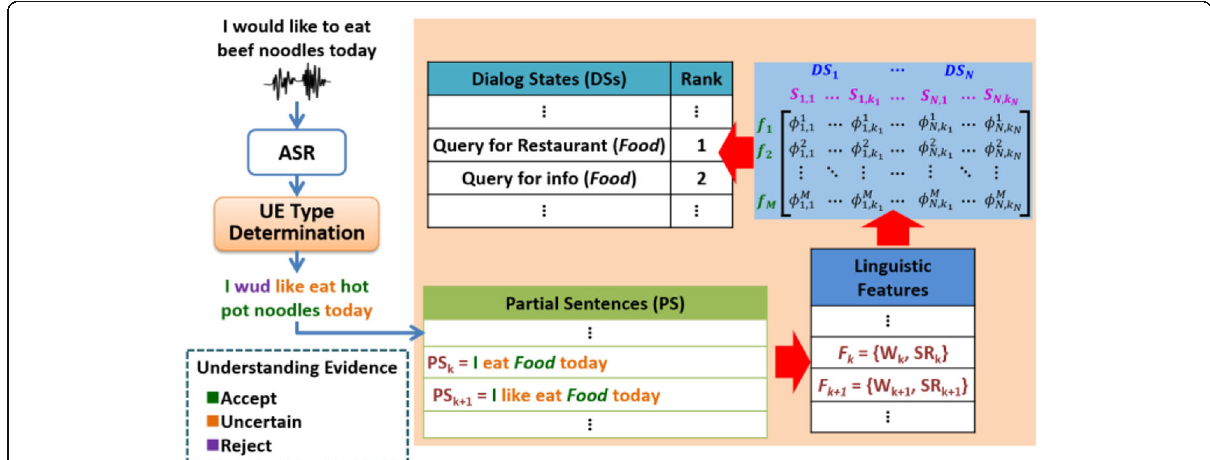
Fig. 8 An example of constructing the linguistic feature-by-DS (LFDS) matrix based on UE